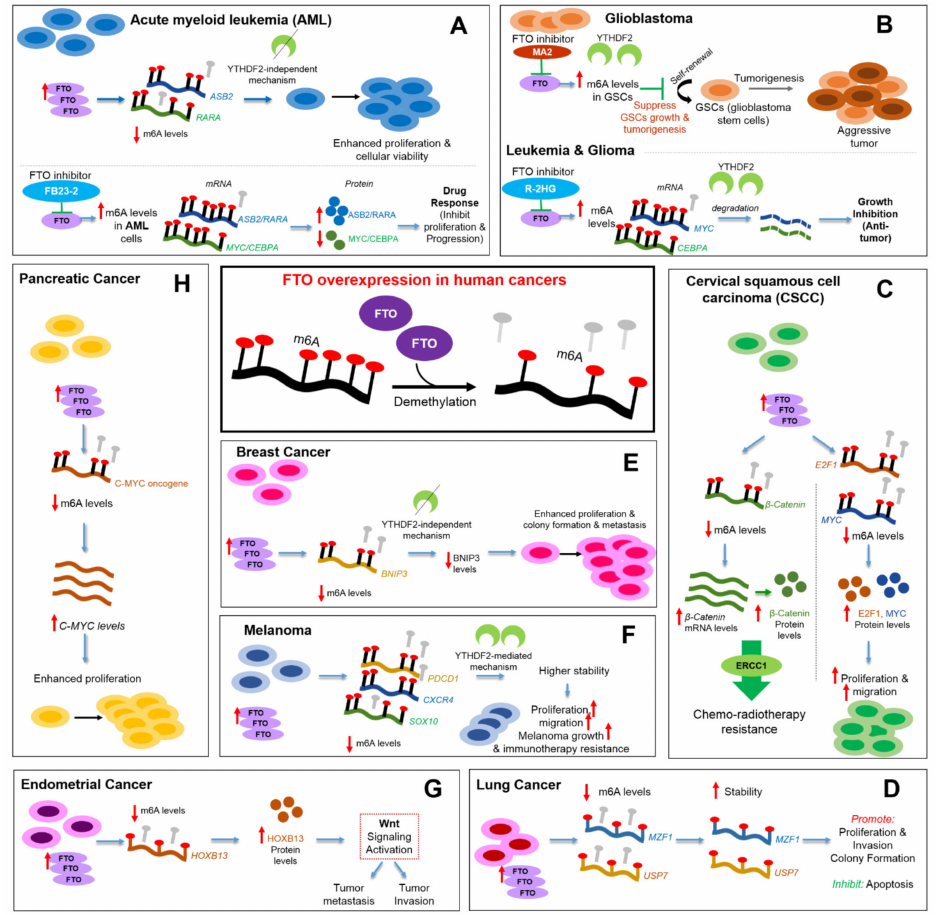
Figure 2. FTO upregulation in various human cancers and its molecular implications as an m6A demethylase, indicated by the regulation of different targets and affected signaling pathways. ( A ) FTO upregulation in AML modulates ASB2/RARA levels, hence, promoting AML cellular viability and proliferation. FTO inhibition via FB23-2 inhibits AML progression, by upregulating ASB2/RARA and downregulating MYC/CEBPA. ( B ) Given FTO’s tumorigenic role in glioblastoma, its inhibition via MA2 suppresses GSCs self-renewal and tumorigenesis. Additionally, inhibiting FTO using R-2HG exerts anti-tumor functions in lethal glioma and leukemia by modulating MYC/CEBPA levels. ( C ) FTO upregulation in CSCC induces chemo-radiotherapy resistance by increasing β - catenin and activating the ERCC1 pathway. E2F1/MYC are also upregulated targets in CSCC that promote oncogenic functions. ( D ) FTO overexpression in lung cancer upregulates MZF1 and USP7 levels via modulating their m6A levels. Thus, promoting lung cancer cells’ proliferation, invasion, and colony formation, while inhibiting their apoptosis. ( E ) In breast cancer cells, FTO upregulation demethylates BNIP3 as a downstream target and downregulates it in a YTHDF2-independent manner, and promoting oncogenic roles like metastasis. ( F ) In melanoma, upregulated FTO and reduced m6A levels, stabilize melanoma-promoting genes namely, PDCD1, CXCR4, and SOX10 in a YTHDF2- mediated process. Consequently, increasing melanoma migration, proliferation, and immunotherapy resistance. ( G ) In endometrial carcinoma, higher HOXB13 expression activates Wnt signaling and promotes metastasis. ( H ) In pancreatic cancer, FTO overexpression leads to upregulating c-MYC oncogene and enhancing pancreatic cancer proliferation. FTO’s additional role as a tumor suppressor in pancreatic cancer is discussed in the text. Abbreviations: ASB2: Ankyrin repeat and SOCS box protein 2; RARA: retinoic acid receptor α ; GSCs: glioblastoma stem cells; MA: Meclofenamic acid; R-2HG: R-2-hydroxyglutarate; ERCC1: excision repair cross-complementation group 1; MZF1: Myeloid Zinc Finger Protein 1; USP7: ubiquitin-specific protease-7; BNIP3: BCL2 Interacting Protein 3; HOXB13: homeobox transcription